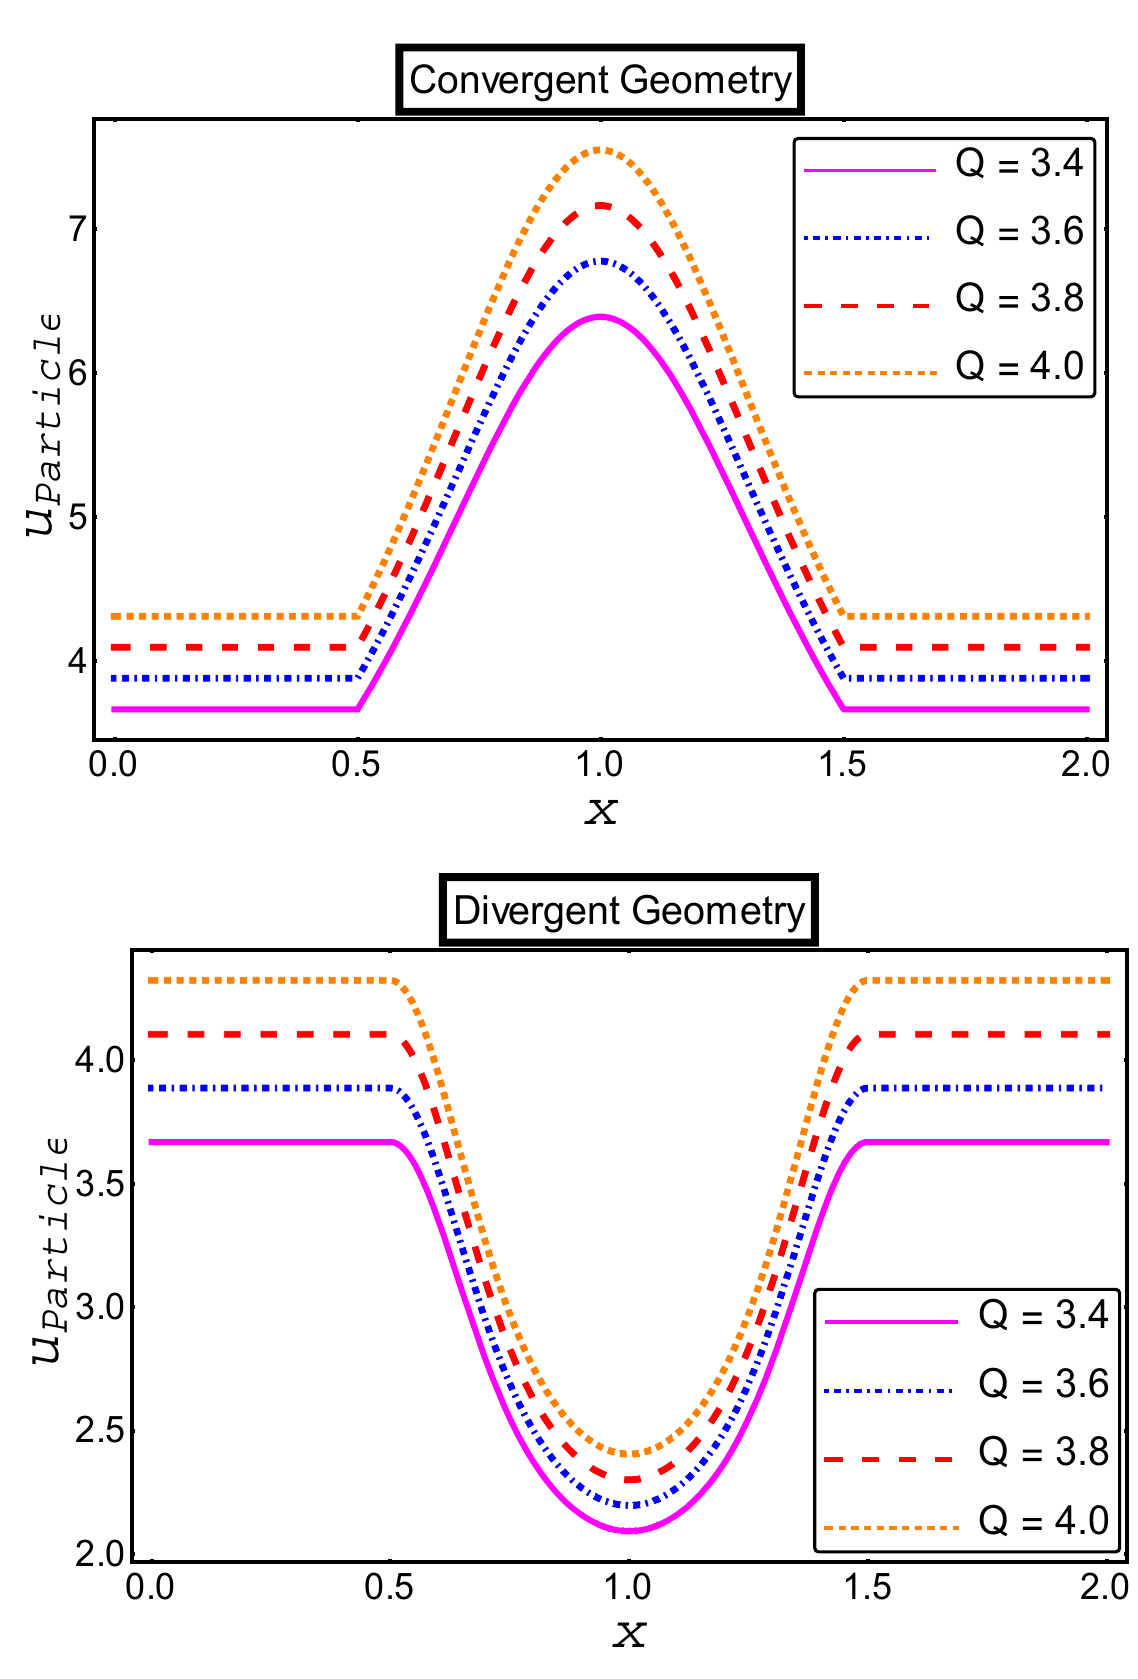
Figure 10. Impact of volumetric fl ow rate on particle velocity.